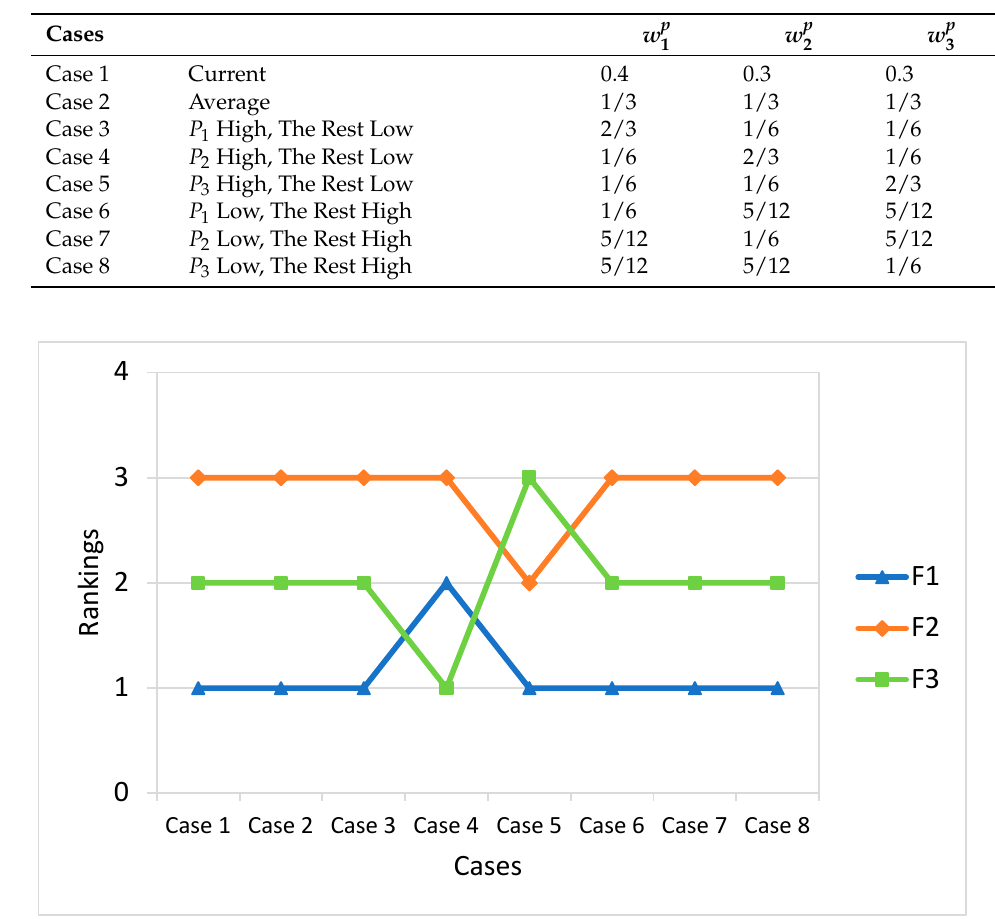
Figure 11. The ranking changes in the sensitivity analysis.